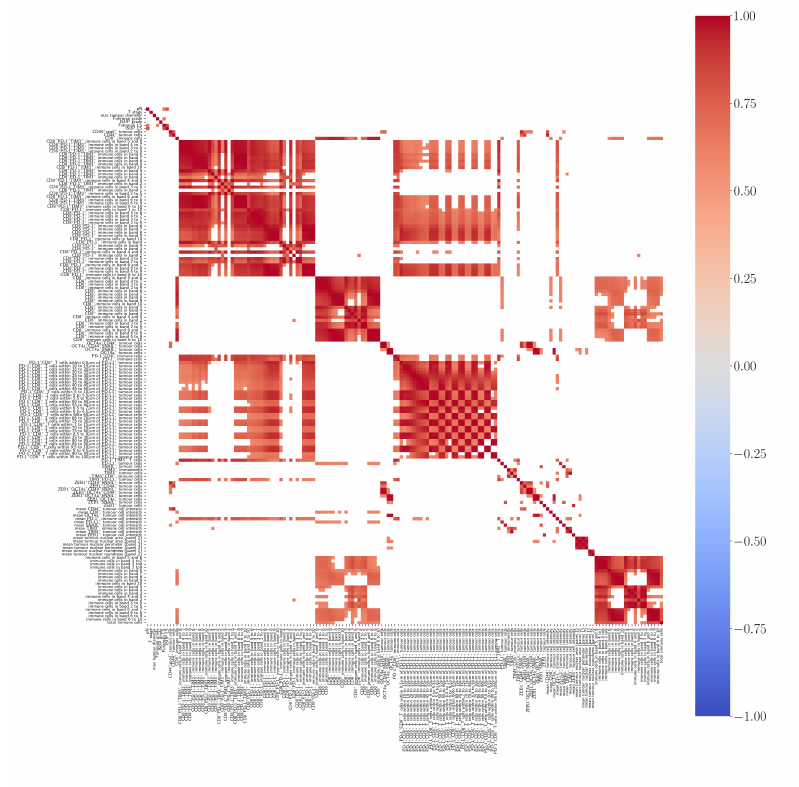
Figure 1. Heatmap showing positive (red), negative (blue), or no (white) correlation among markers assessed in the whole slides (WSs) after unsupervised clustering. A total of 156 features were assessed, including morphological features, molecular marker combination in tumour and immune cells, and spatial analysis data. Only correlations with p < 0.05 after Chow–Denning correction are shown. No negative correlations were